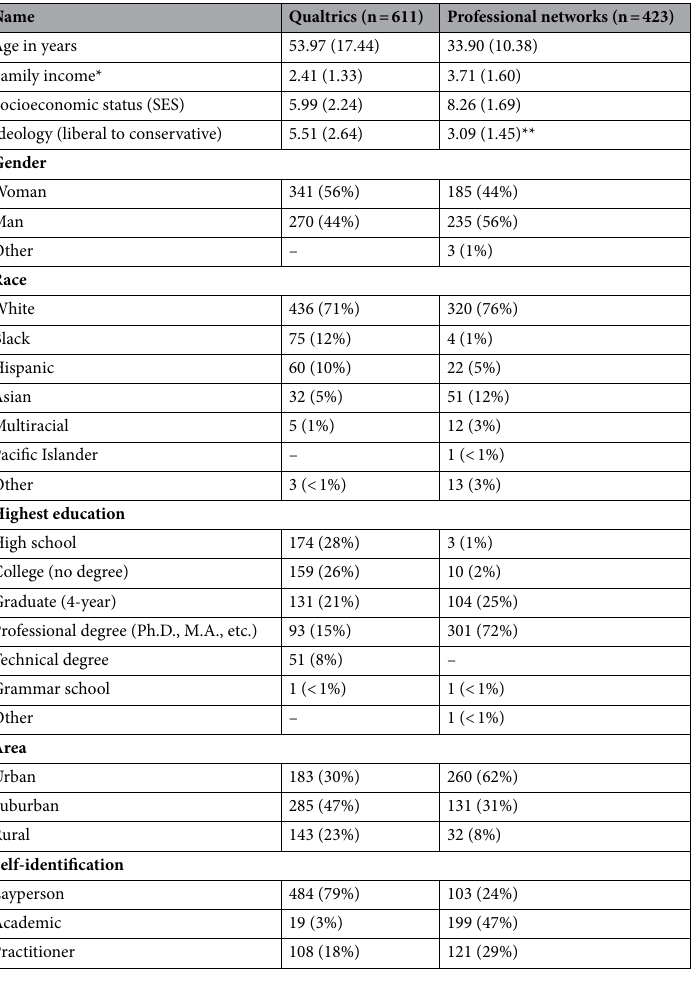
Table 1. Sample demographics, qualtrics versus professional networks. Values are means (SDs) or counts (frequencies) unless otherwise noted. *1 = “Below 30k”, 2 = “30–60k”, 3 = “60–90k”, 4 = “90–120k”, 5 = “Above 120k”. **Missing two participants’